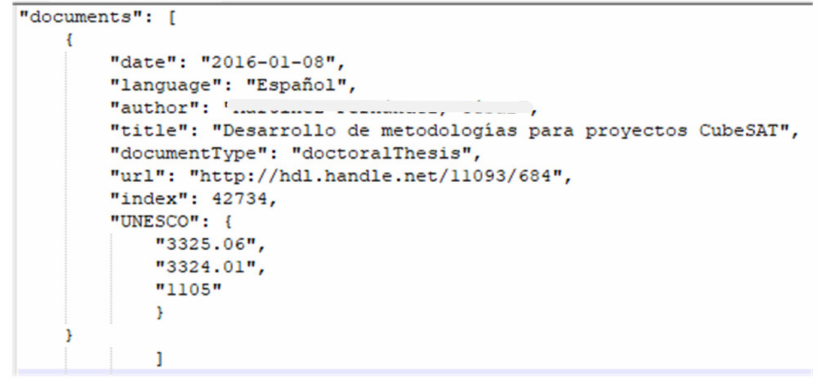
Figure 2. Document object